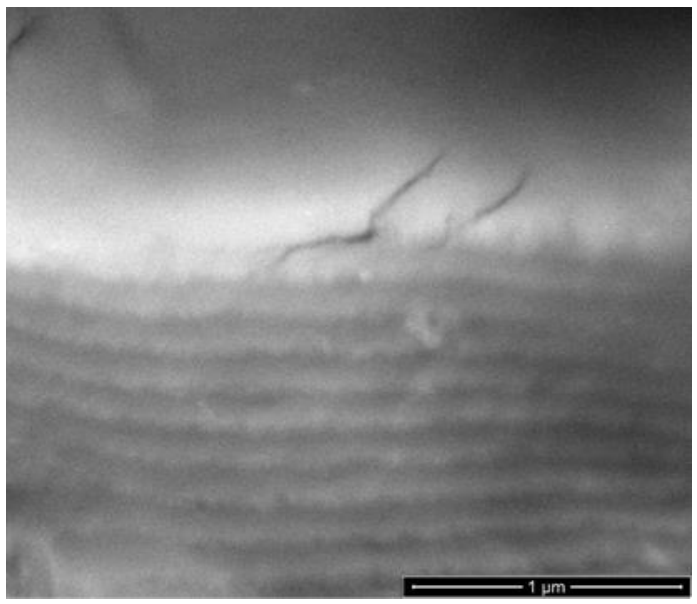
Figure 16. Cracks, detected in the coating of a T3 tool, tested at 75% feed rate and 4 m of cutting length.